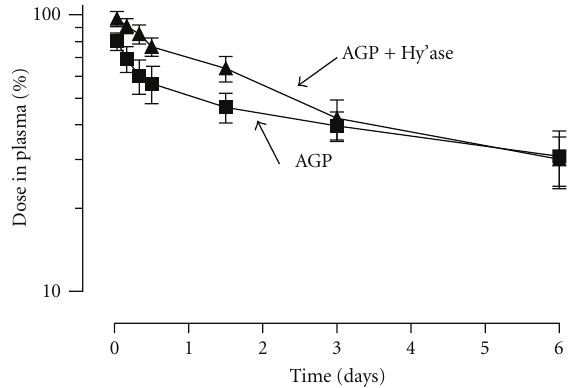
Figure 5: The disappearance of injected AGP from the plasma of mice following intravenous injection is altered by systemic hyaluro- nidase treatment. Radioiodinated AGP was injected into mice with (AGP + hy’ase) or without (AGP) concurrent hyaluronidase treat- ment, and acid-precipitable radioactivity, shown as the percentage of the dose remaining in plasma, was followed over time, n = 6 ±